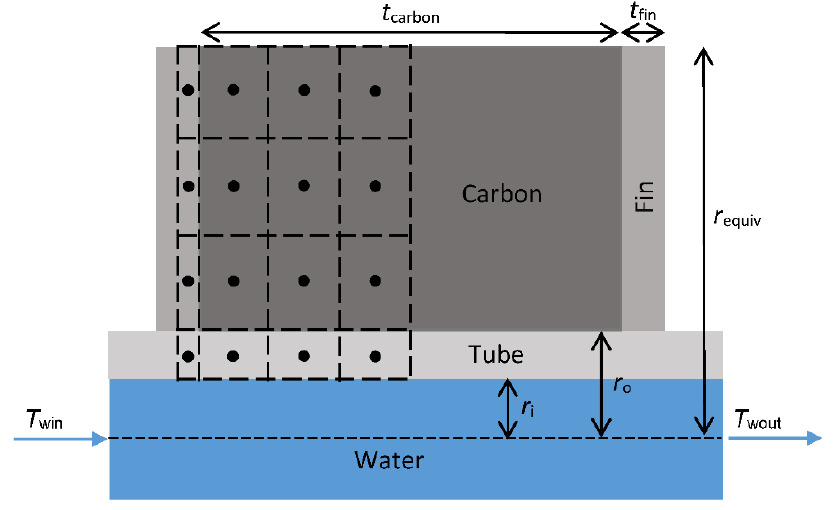
Figure 10. Discretization of the control volume in the finite difference model.